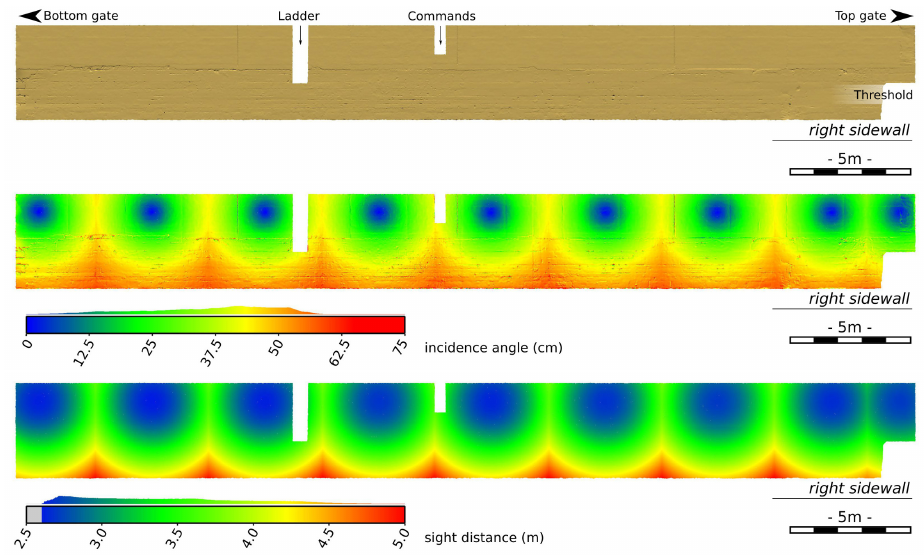
Figure 6. (top) TLS mesh of the right sidewall of the lock chamber (reference): the two indentations correspond to a ladder and to a groove used for the lock paddle commands, the threshold is visible on the right; (middle) incidence angles; (bottom) sight